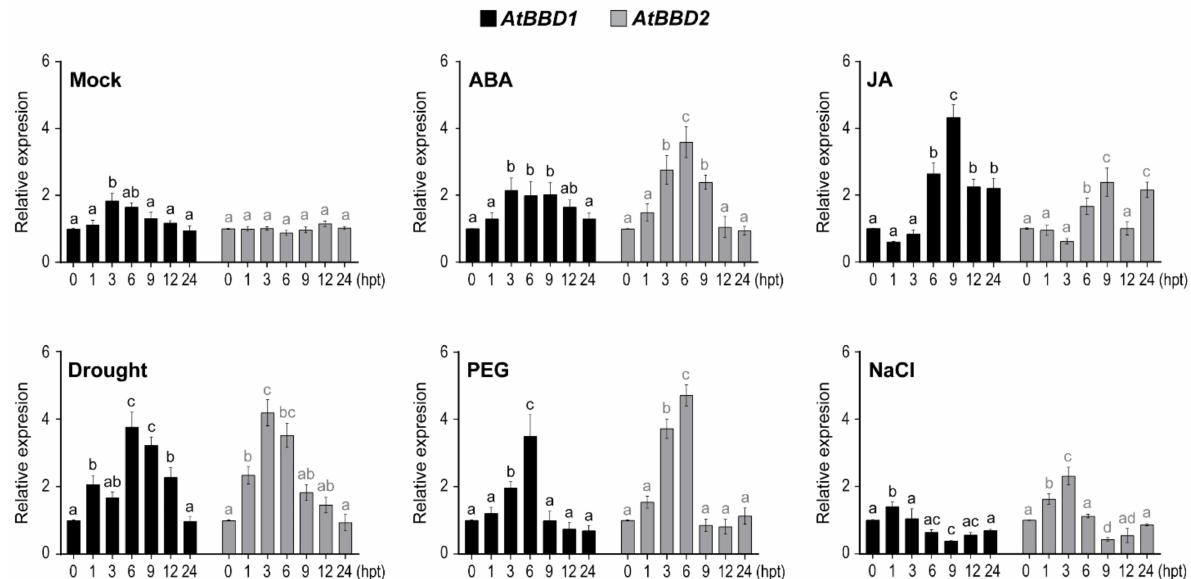
Figure 2. Expression of AtBBD1 and AtBBD2 genes in Arabidopsis at various times in response to abiotic stresses. The gene expression was analyzed by qRT-PCR. Two-week-old Arabidopsis (Col-0) plants grown on 1/2 MS agar media were treated with 100 µ M abscisic acid (ABA) or 100 µ M jasmonic acid (JA) or kept in a lamina flow hood for the dry condition, or transferred to 1/2 MS liquid media containing 20% PEG 6000 (PEG), or were transferred to 1/2 MS liquid media containing 200 mM NaCl. The gene expression was calculated and normalized to the reference gene eIF4a1 . The normalized mRNA levels in mock-treated wild-type plants at 0 h were set to 1. The relative gene expression values in response to treatments were normalized to mock for each time point. Data represent the mean ± standard error values of three independent experiments. One-way ANOVA with post-hoc Tukey test was used for the statistical comparison of all time points. Different letters indicate significant differences among times for each gene after treatment ( p <